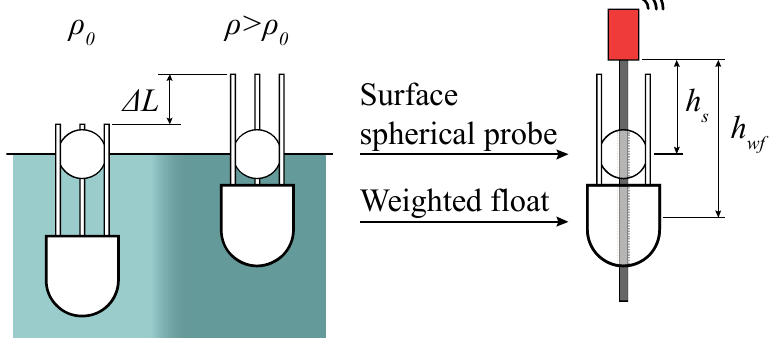
Figure 1. Operating principle of the density meter. A spherical probe floats at the water surface, while a semi-floating probe is partly immersed. The immersion depends on the water density. The MS sensor accurately measures the displacement difference between the two probes, from which the density is